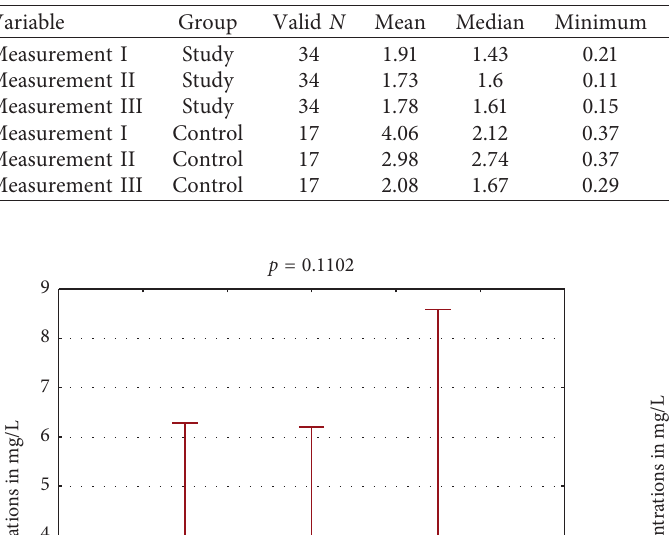
Table 1: CRP concentrations in mg/L—statistical analysis—study and control groups.